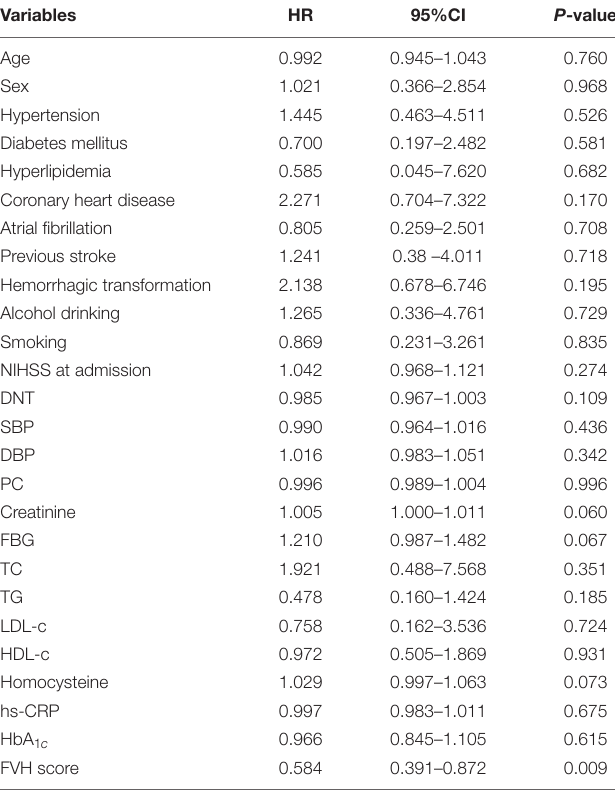
TABLE 3 | Cox regression analysis in patients with poor prognosis.